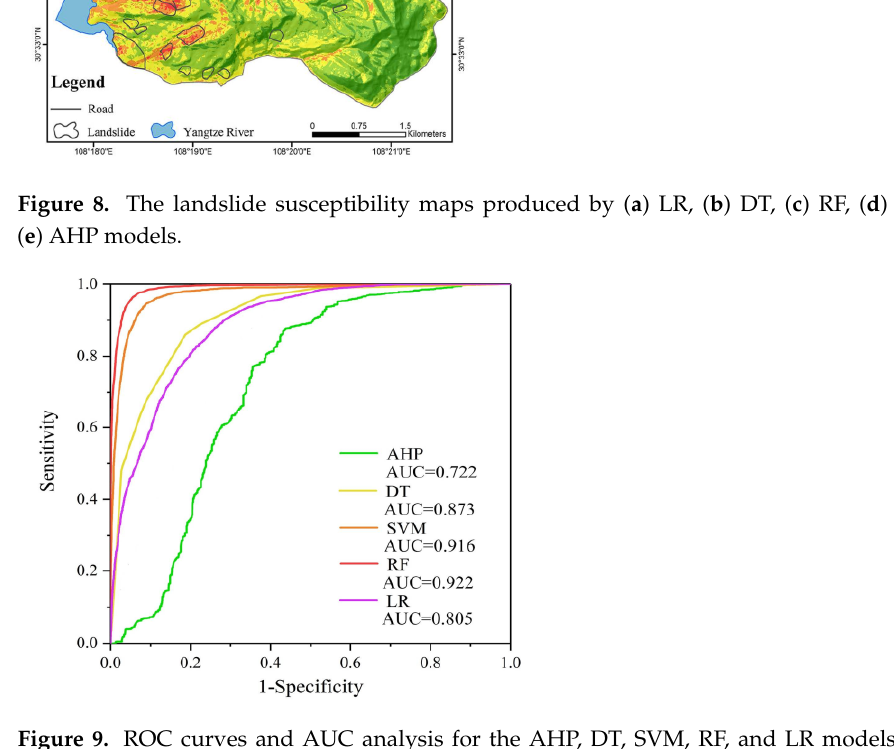
Figure 9. ROC curves and AUC analysis for the AHP, DT, SVM, RF, and LR models using the validating